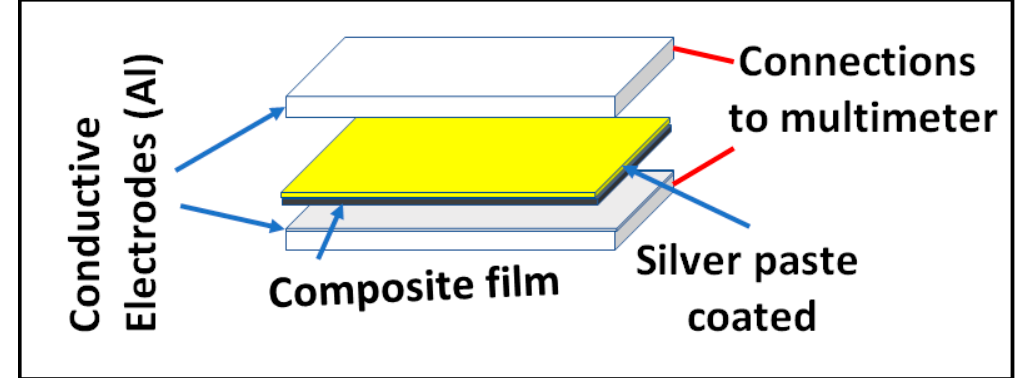
Scheme 1. Schematic representation of the sensor layers and connections.